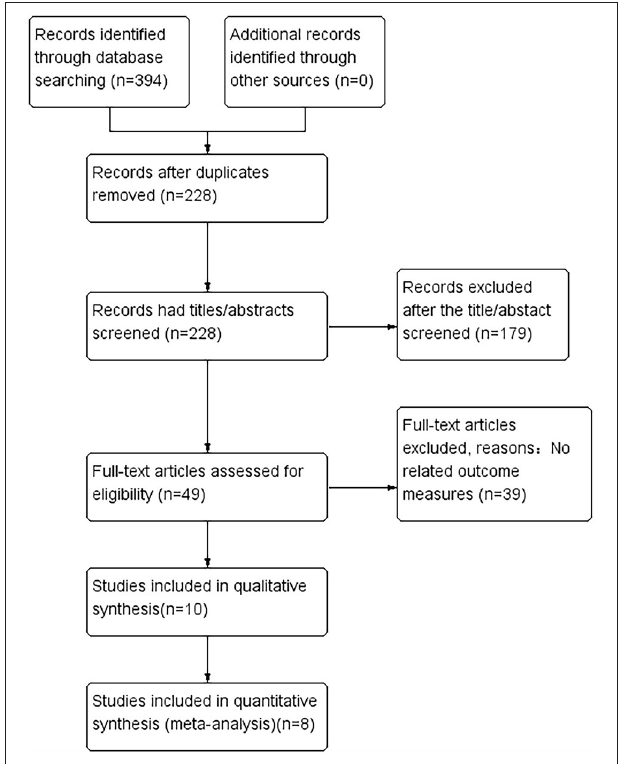
FIGURE 1 | Study flow